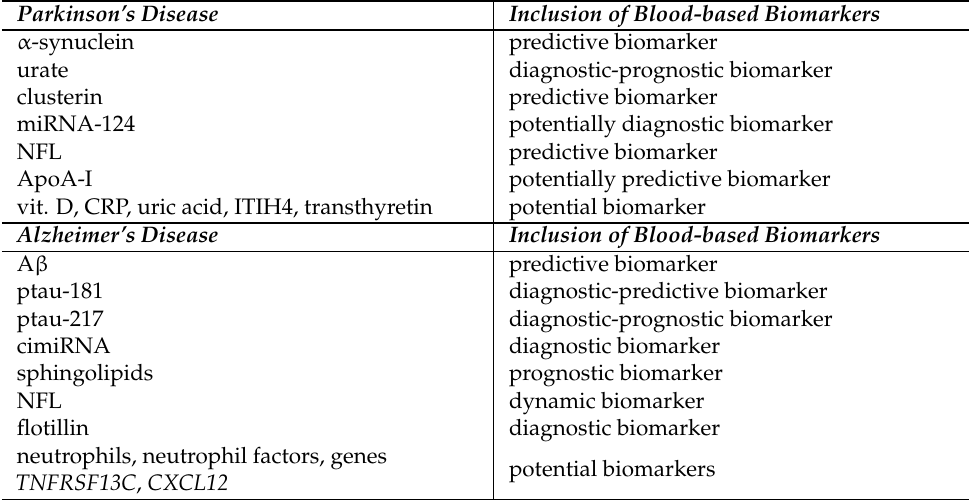
Table 2. Overview of blood biomarkers in PD and